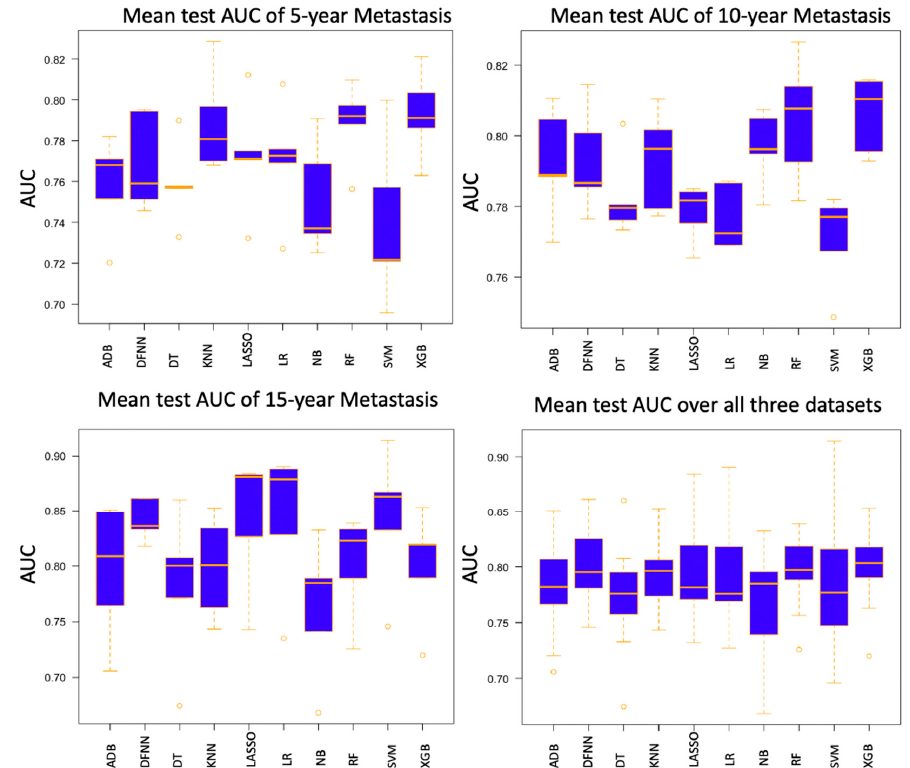
Figure 5. Boxplots to compare the mean test AUCs of all methods (AUC: area under the ROC curves;